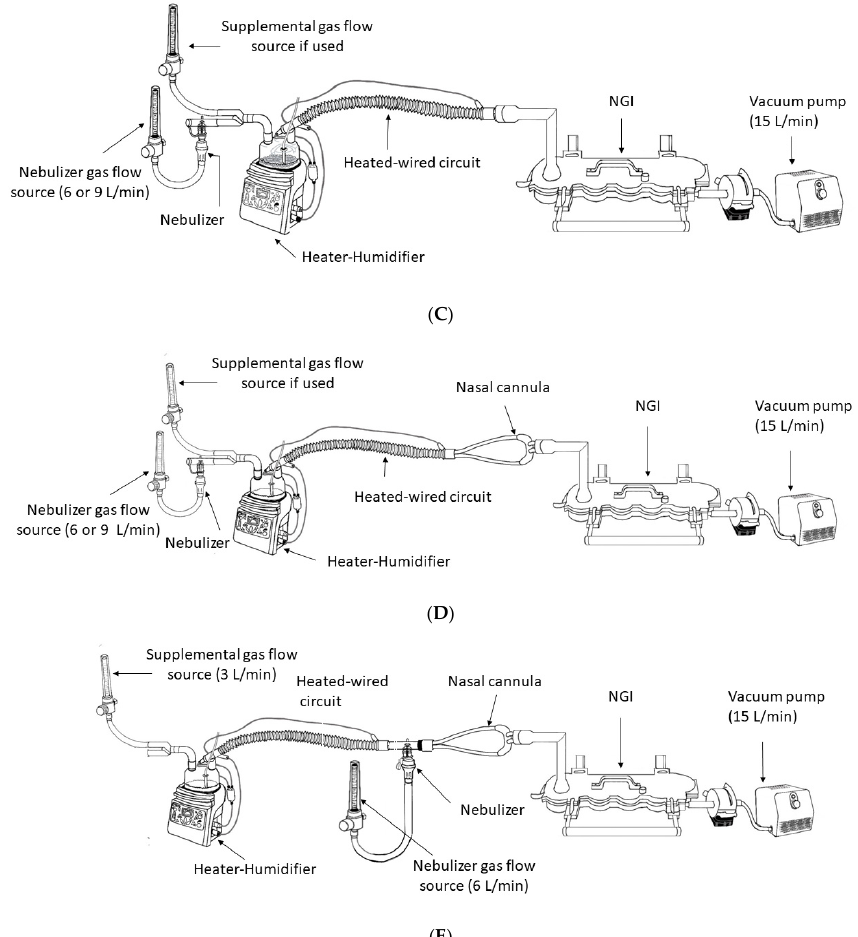
Figure 5. (A) Nebulizer with the Tee-piece connected to the induction port of the Next Generator Impactor (NGI). ( B ) Nebulizer with the Tee-piece connected to the Y-piece and connected to the induction port of the Next Generator Impactor (NGI). ( C ) Nebulizer with the Tee-piece connected to the Y-piece, connected to the humidifier inlet, connected to the heated-wired circuit and connected to the induction port of the Next Generator Impactor (NGI). ( D ) Nebulizer with Tee-piece connected to Y-piece, connected to the humidifier inlet, connected to the heated-wired circuit, connected to nasal cannula that was connected to the induction port of the Next Generator Impactor (NGI). ( E ) Nebulizer with Tee-piece placed between the heated-wired circuit and a large cannula that was connected to the induction port of the Next Generator Impactor (NGI). The outcome measures were the mass median aerodynamic diameter (MMAD), ge- ometric standard deviation (GSD), albuterol mass captured in the NGI from stage 1 to internal filter (MASS) fine particle fraction (mass of particles <5 µm in MASS/MASS *100) (FPF), and were calculated with CITDAS V3.1 software (Copley Scientific, Nottingham,